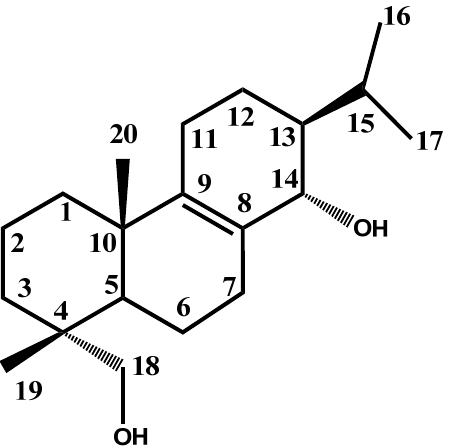
Figure 1. The structure of